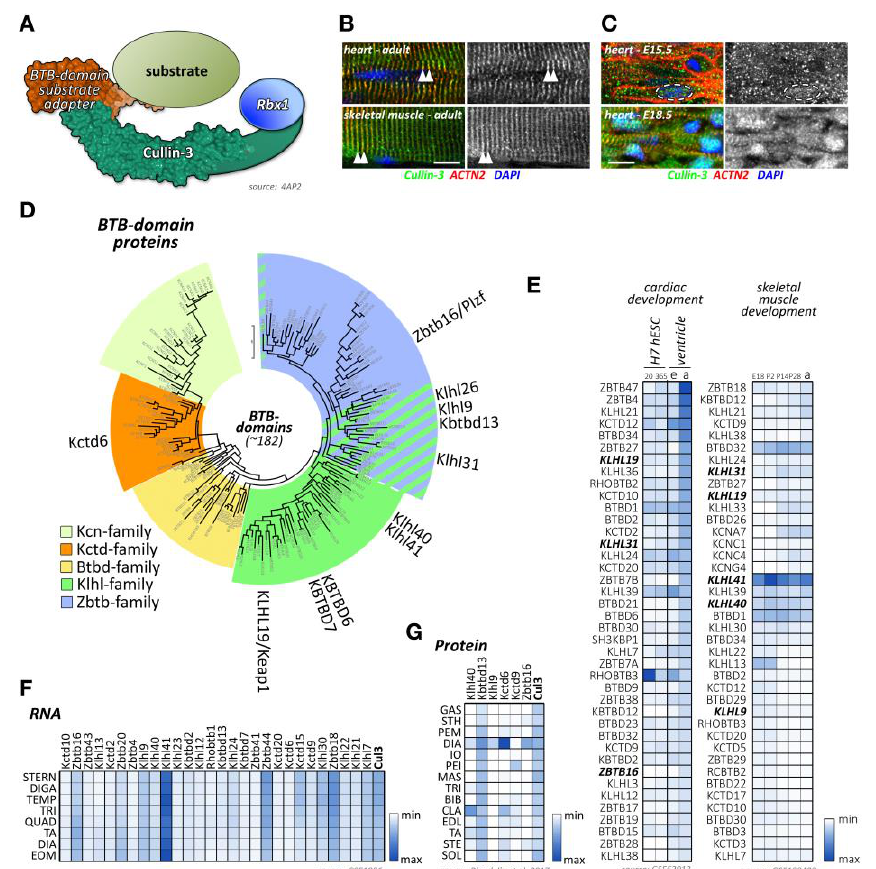
Figure 5. Cullin-3 and its substrate adapters. ( A ) Schematic presentation of the cullin-3-based E3-ligase with a BTB-domain-containing substrate adapter. Surface representation is from structure 4AP2 [210]. ( B , C ) Localization of cullin-3 (green) in mouse adult heart and skeletal muscle ( B ), and mouse embryonic heart at E15.5 and E18.5. ( C ) Tissues were counterstained with antibodies against sarcomeric actinin (ACTN2, red) and DAPI. Arrowheads highlight the sarcomeric Z-disk (B). Dashed line in ( C ) marks the boundaries of a single cardiac nuclei. Scale bar = 10 µ m. ( D ) Maximum likelihood molecular phylogenetic tree analysis of human BTB-domain-containing proteins. Shown are di ff erent BTB-domain-containing substrate adapter families. Cullin-3 substrate adapters with known functions for cross-striated muscles are highlighted. ( E ) Heatmap analysis of BTB-domain-containing substrate adapter mRNA expression levels during cardiac development (left panel) and skeletal muscle development (right panel). Left panel shows analysis of cardiac di ff erentiation of H7 human embryonic stem cells into cardiomyocytes. Cells were analyzed at day 20 and day 365 in culture. Expression levels of adapter proteins in the ventricular tissue of mouse embryonic (e) or adult hearts (a) are also depicted. Right panels display analysis of murine skeletal muscle di ff erentiation at embryonic day E18, and postnatal days 2, 14, 28, and adult stages. Note that only the top 40 proteins with the highest mRNA levels in cardiac and skeletal muscles are depicted. BTB-domain-containing adapter proteins with known functions for heart and / or skeletal muscles are highlighted in bold. Data were adapted from datasets GSE62913 and GSE108402 [91,92]. ( F ) Muscle-type specific mRNA expression analysis of BTB-domain-containing adapter proteins, as well as cullin-3. Analyzed adult muscles were sternomastoid (Stern), digastric (Diga), temporalis (Temp), triceps (Tri), quadriceps femoris (vastus lateralis; Quad), tibialis anterior (TA), diaphragm (Dia), and extraocular muscle (Eom). Data were adapted from GSE1806 [93]. ( G ) Protein expression heatmap of select cullin-3 substrate adapter proteins in various adult mouse skeletal muscles. The following muscle-types were analyzed: gastrocnemius (Gas), sternohyoideus (Sth), pectoralis major (Pem), diaphragm (Dia), internal oblique (Io), pectoralis minor (Pei), massester (Mas), triceps (Tri), biceps brachii (Bib), clavotrapezius (Cla), extensor digitorum longus (Edl), tibialis anterior (Ta), sternomastoideus (Ste), and soleus (Sol). Adapted from [ 206] .